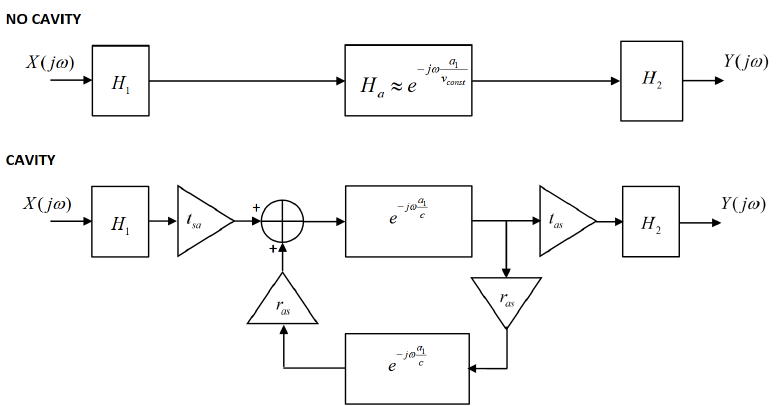
Figure 2. The propagation of an EM wave across soil that either does or does not contain a cavity, modeled as one of two